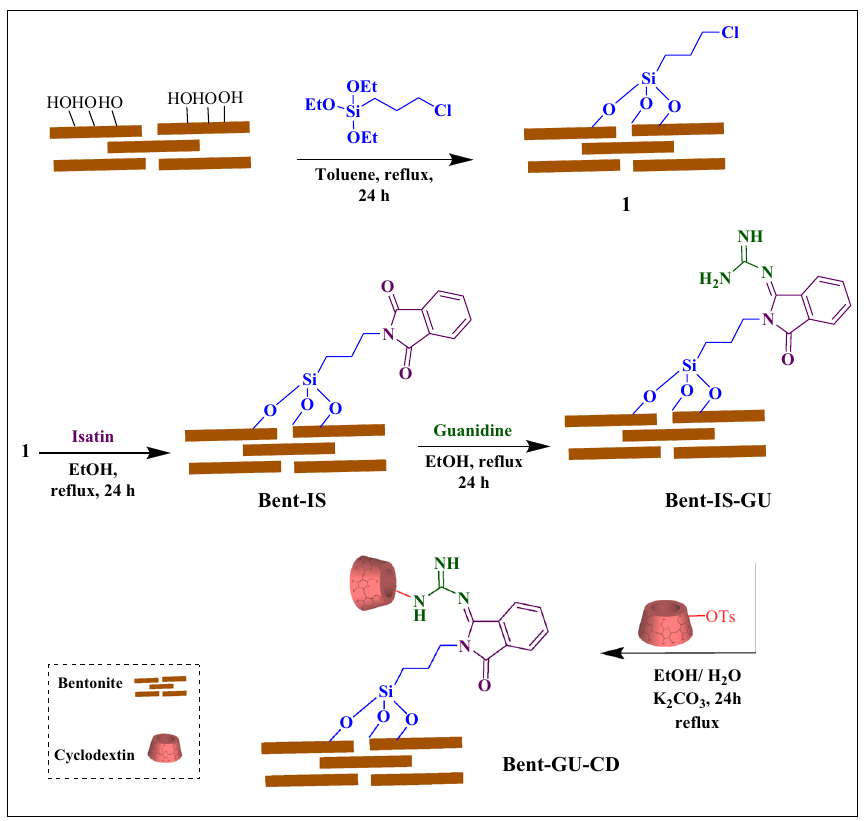
Figure 1. Schematic diagram for the synthesis of Bent-Gu-CD.